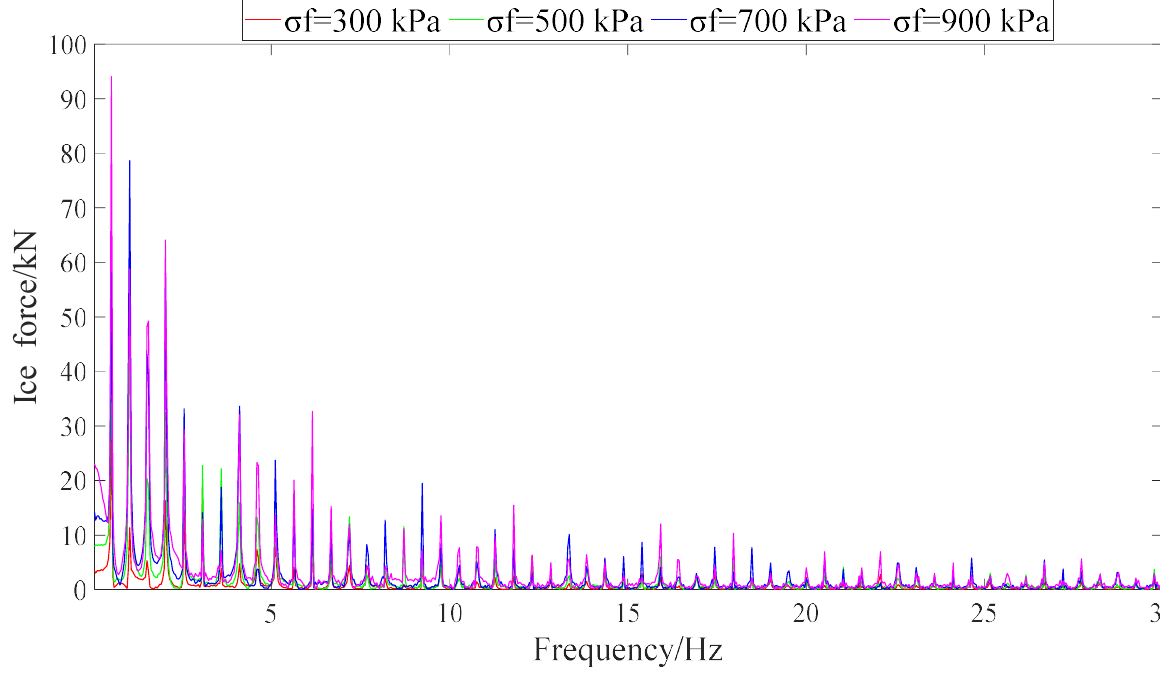
Table 8. Statistics of ice force under different bending strength ( σ f ).